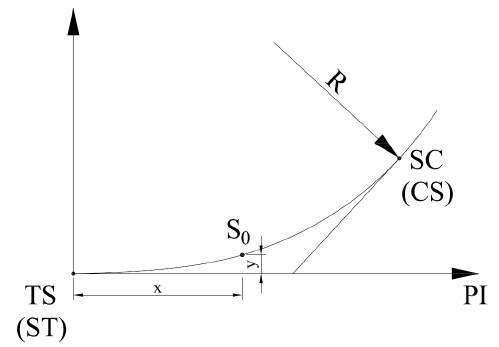
Figure 3. Schematic diagram of the tangent offset method.